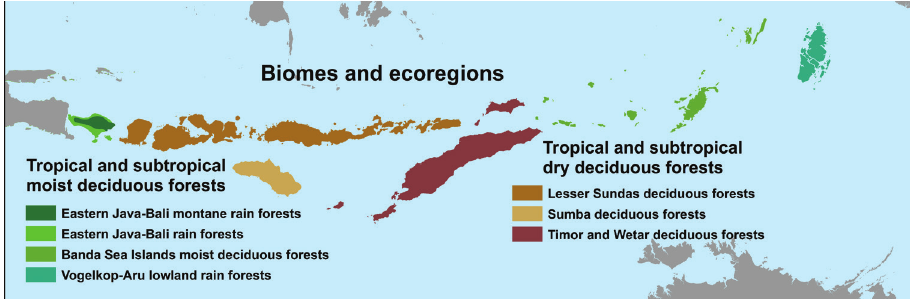
Figure 2. Seven ecoregions in two biomes of Lesser Sunda Islands following the Terrestrial Ecoregions of the